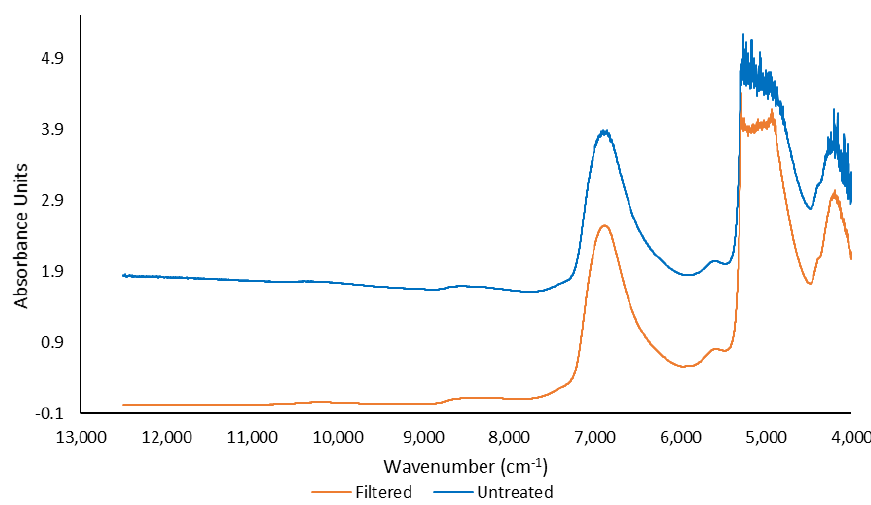
Figure 2. Average filtered and untreated spectra for T-FT-NIR spectroscopy.